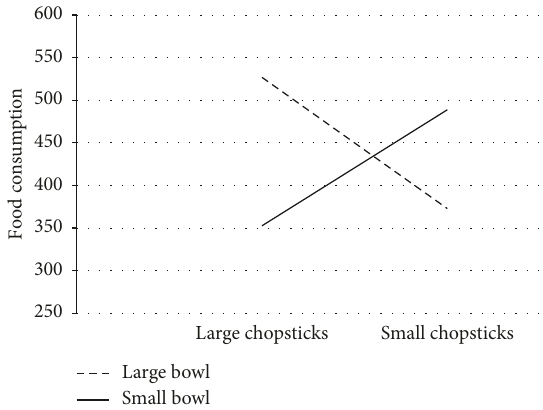
Figure 1: Influences of bowl size and chopstick size on food